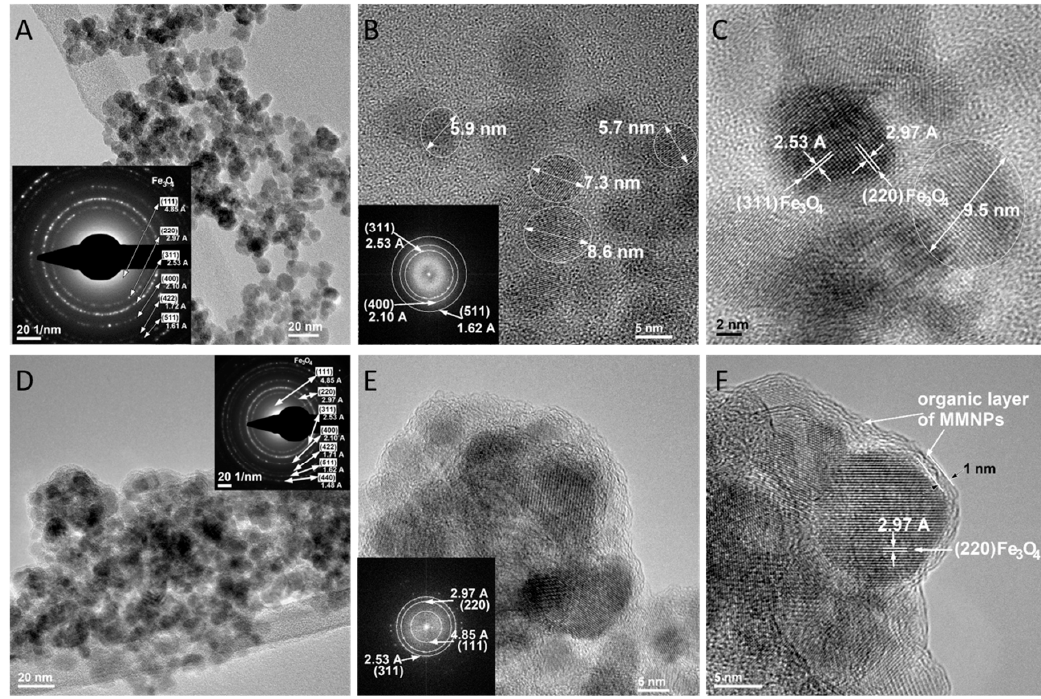
Figure 10. TEM images on Fe 3 O 4 nanoparticles ( A–C ) and modified F 3 O 4 nanoparticles ( D–F )